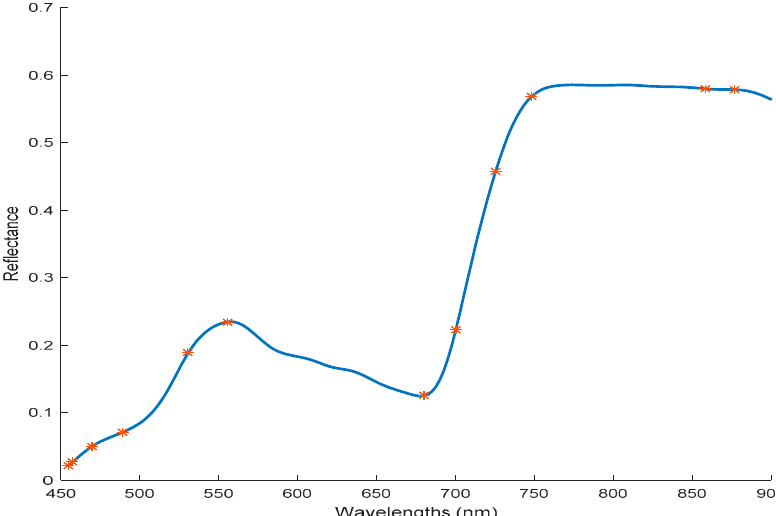
Figure 7. Effective variables selected by successive projections algorithm (SPA).